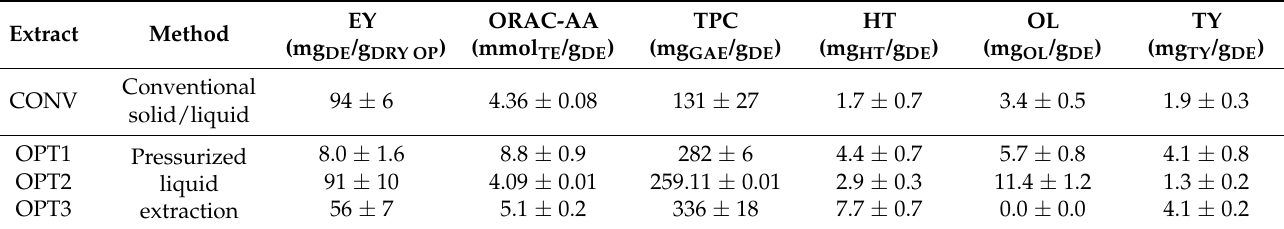
Table 1. Characterization of the conventional (CONV) and the three optimized (OPT1, OPT2, and OPT3) olive pomace (OP) extracts in terms of extraction yield (EY) (as mg of dry extract (DE)/g of DRY OP), oxygen radical absorbance capacity antioxidant activity (ORAC-AA) (as mmol of Trolox equivalents (TE)/g of DE), and total phenolic content (TPC) (as mg of gallic acid equivalents (GAE)/g of DE), as well as extract richness in Hydroxytyrosol (HT), Oleuropein (OL) and Tyrosol (TY) (as mg of compound/g of DE). The results are presented as average ± standard deviation.